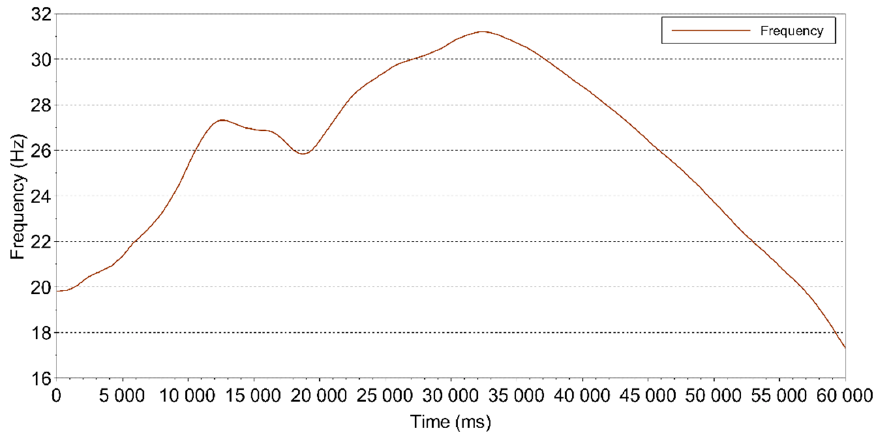
Figure 12. Frequency at the inverter output by wind speed variations.